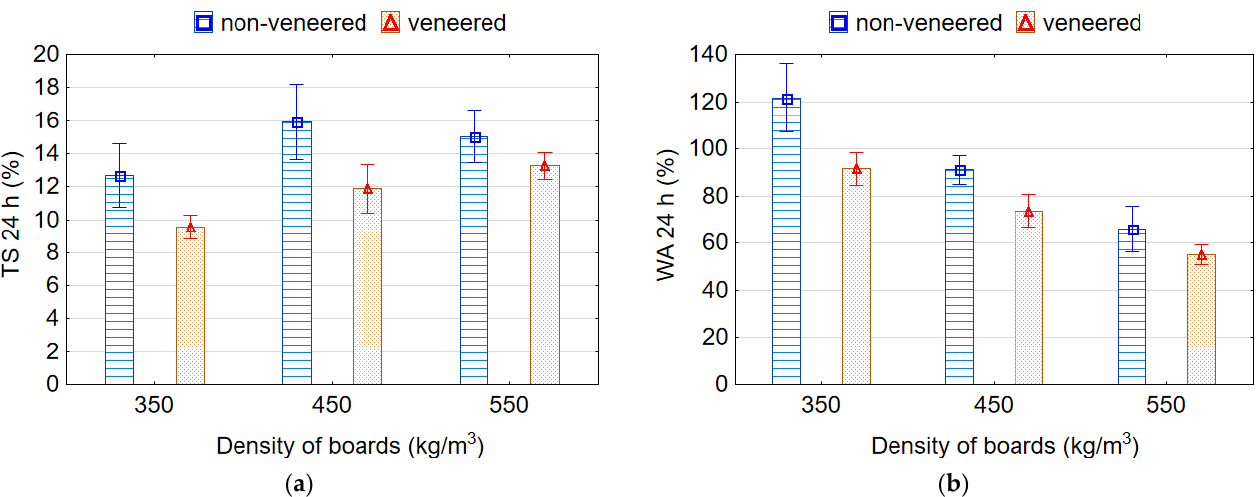
Figure 11. Thickness swelling ( a ) and water absorption ( b ) of non-veneered and veneered lightweight particleboards.